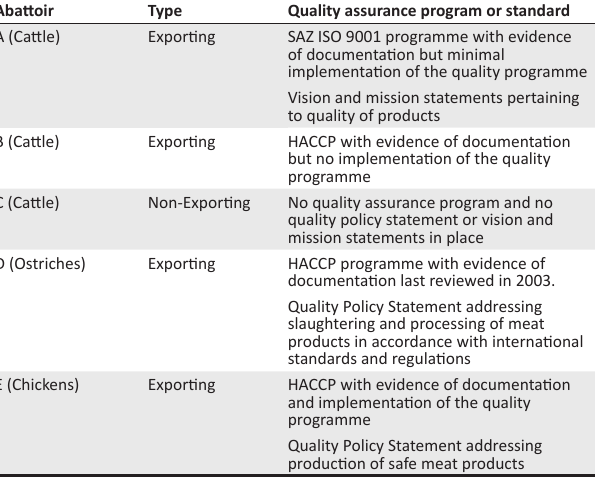
TABLE 2: Quality management systems used in the five selected abattoirs. Abattoir